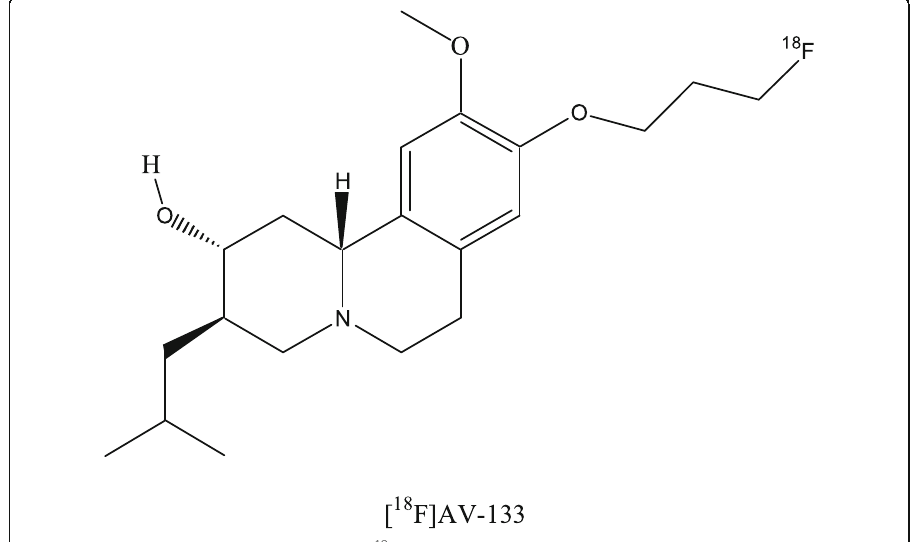
Fig. 6 Chemical structure of (2R,3R,11bR)-9-(3-[ 18